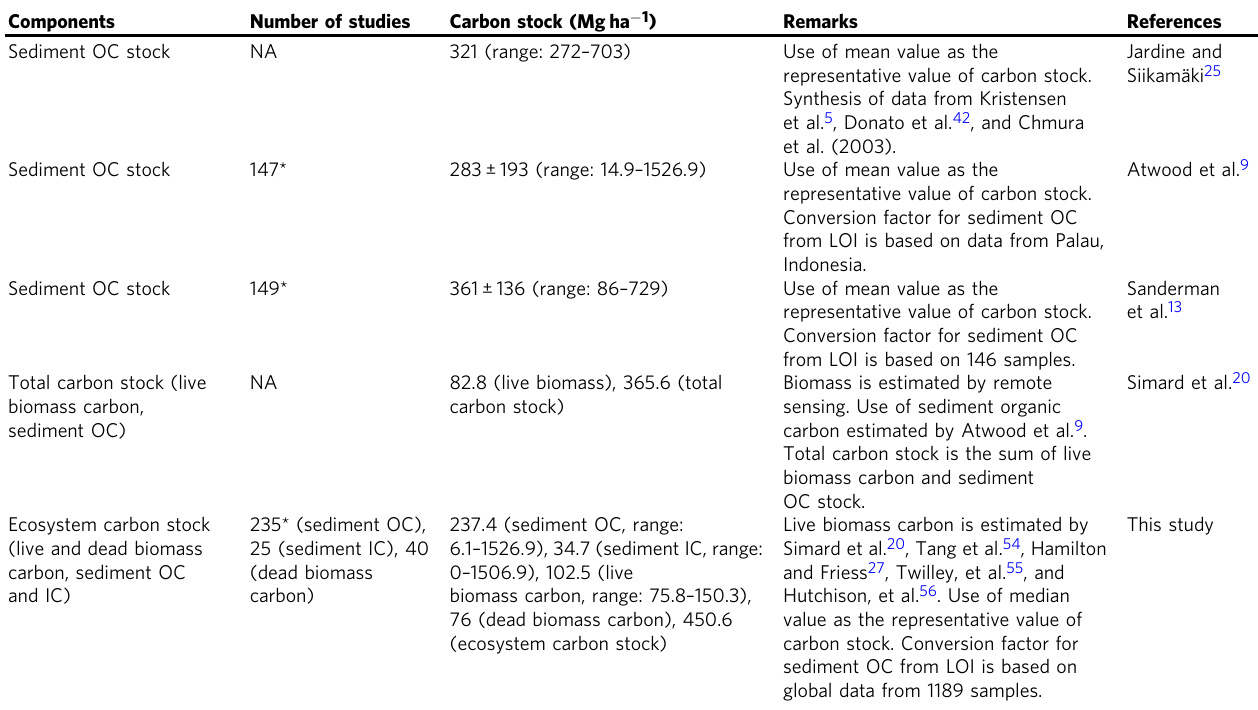
Table 1 Comparison of global mangrove sediment and ecosystem carbon stocks estimated in this study with published values. NA not available; *including data from a few unpublished